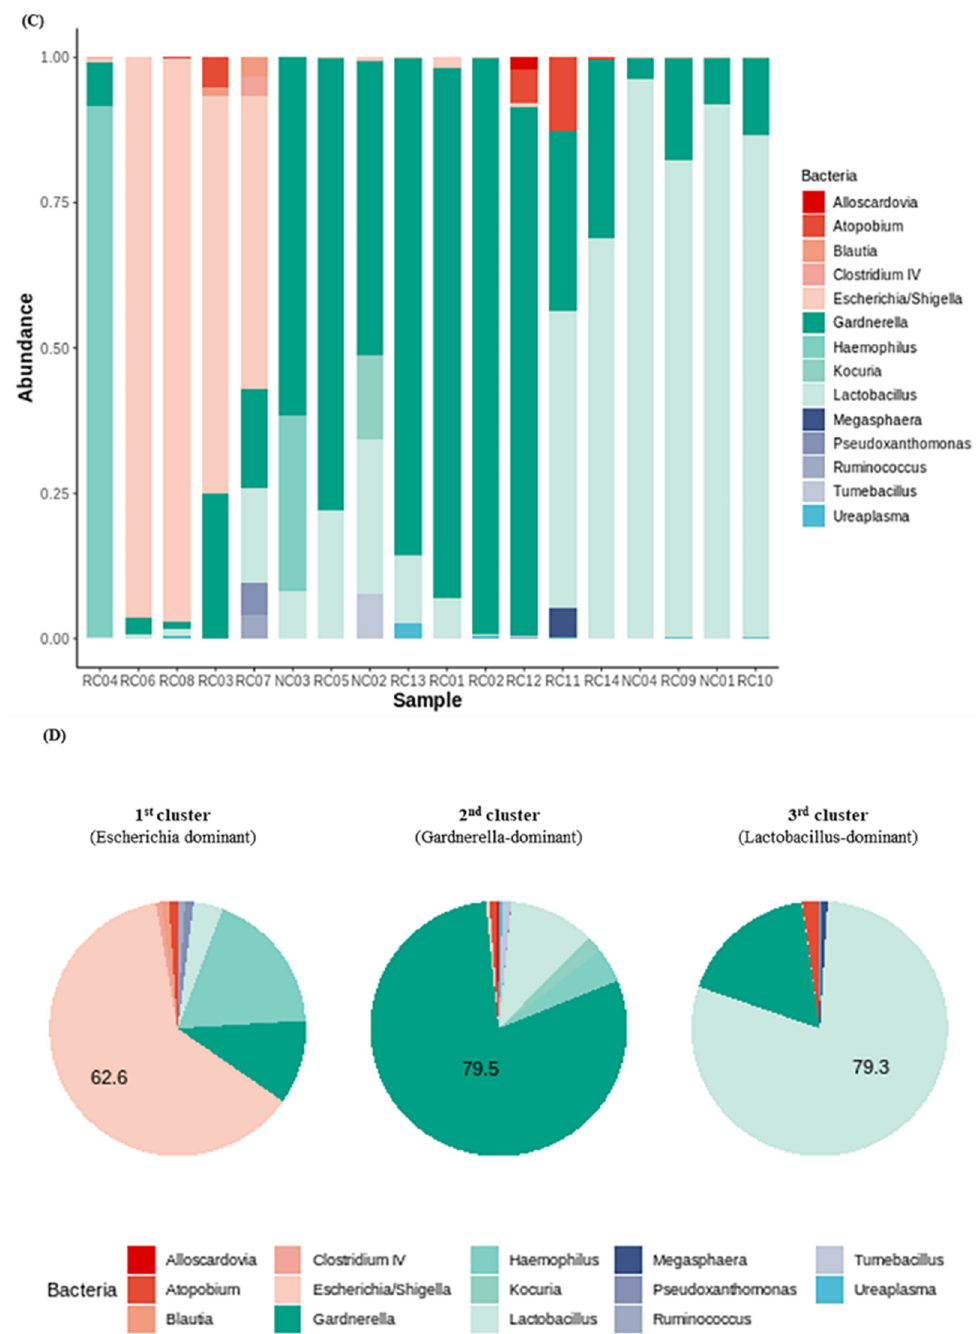
Figure 3. Gardnerella (+) urinary microbiota revealed three distinct subgroups by ( A ) K-medoids clustering and ( B ) hierarchical clustering in R program version 4.1.2 (The R Foundation for Statistical Computing, Vienna, Austria; https://svn.r-project.org/R-packages/trunk/cluster, accessed on 17 March 2021), ( C ) bar plot, ( D ) pie chart.